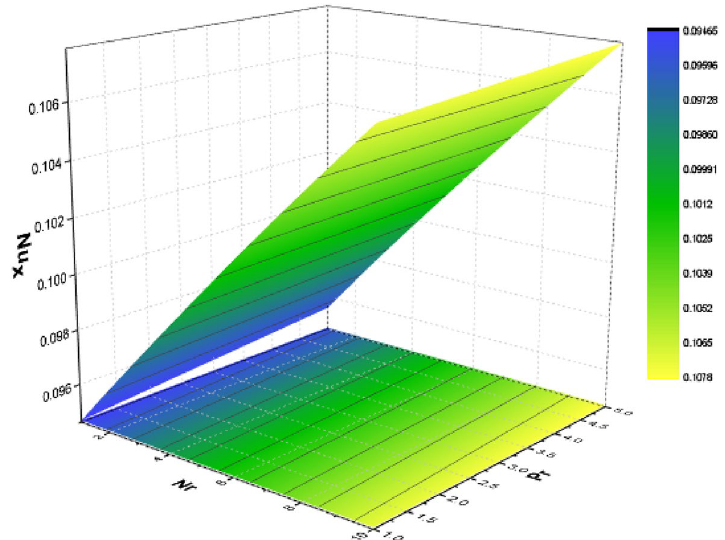
Figure 14. Effect of Nr and Pr on NN.